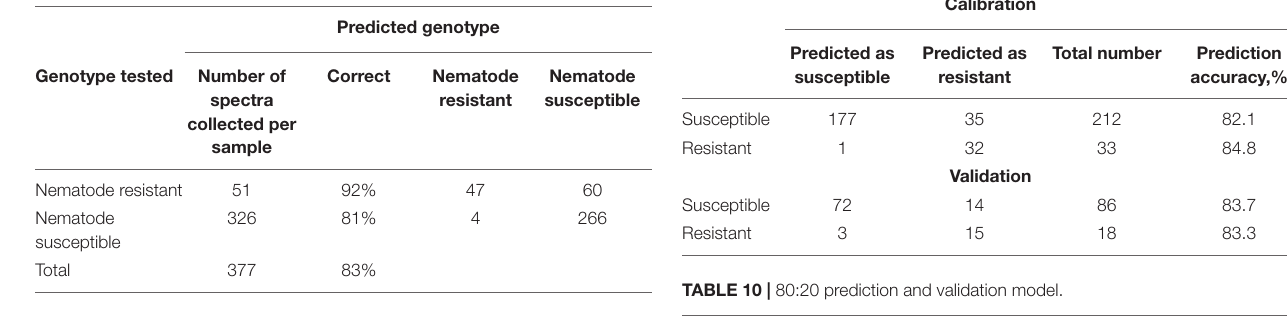
TABLE 5 | PLS-DA cross-validation confusion matrix of Raman spectra collected from leaves of nematode-resistant and susceptible peanut varieties.